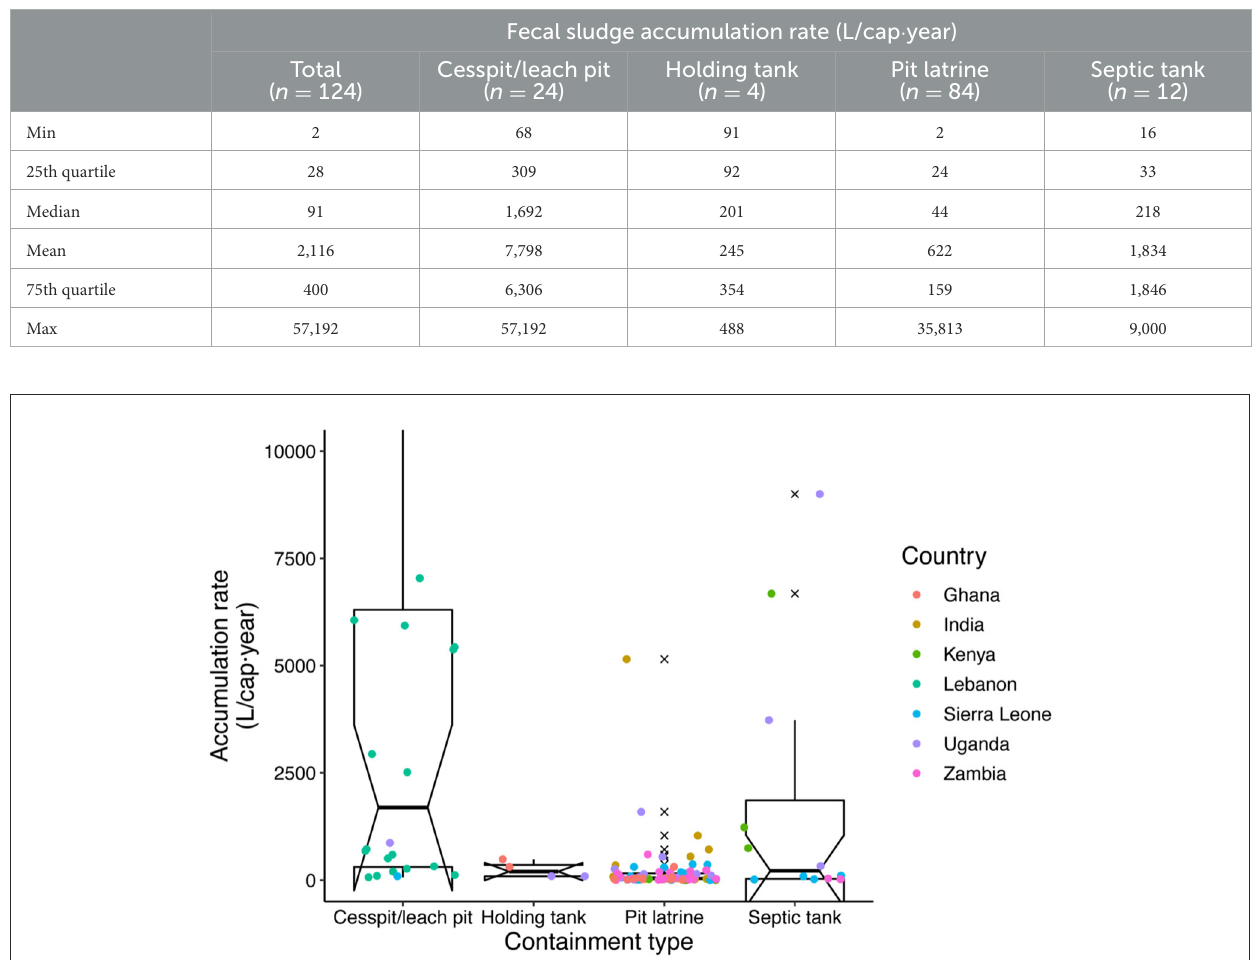
FIGURE8 Boxplot of fecal sludge accumulation rate by containment type. The y-axis is capped at 10,000 L/cap · year to improve readability, but actually runs until 60,000 L/cap · year. Notches in boxplots show confidence interval around the median, outliers are marked with a ×